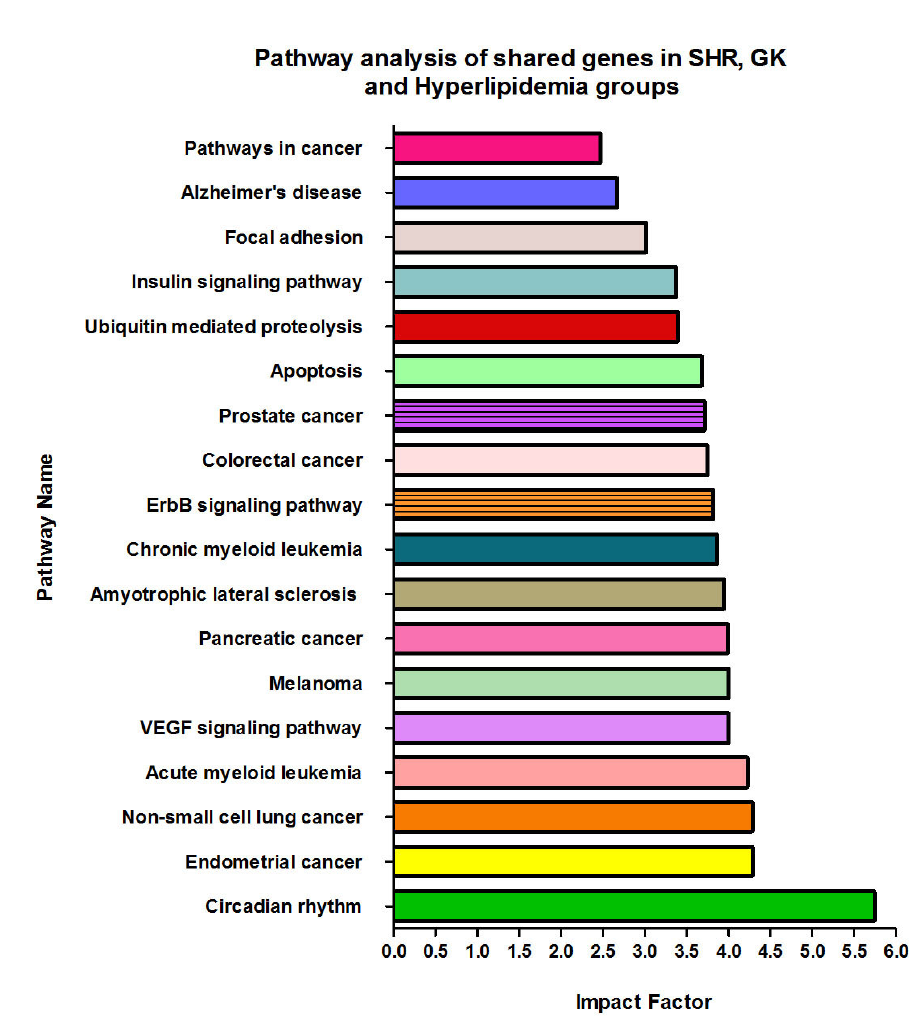
FIGURE 5 - Pathway analysis of shared genes in SHR, GK and HMR using Onto-tools Pathway Express. Pathways were associated with the circadian rhythm pathway, endometrial cancer pathway, pancreatic cancer pathway,